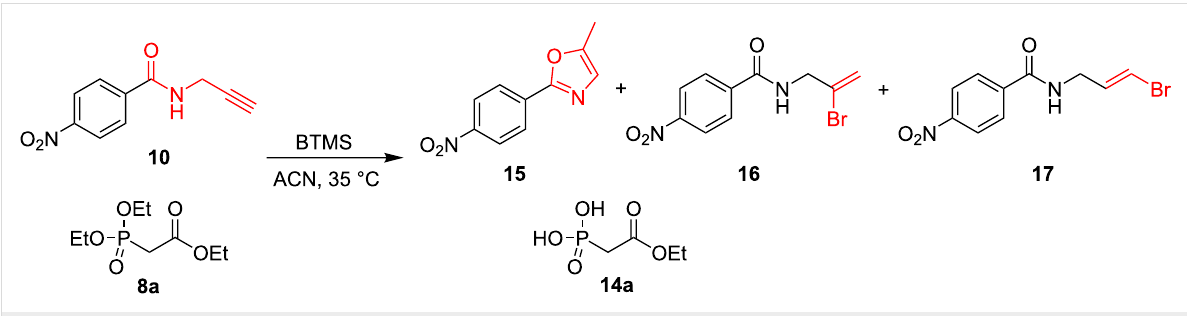
Scheme 2: Formation of the side products derived from 10 . Conditions: An equimolar mixture of propargylamide 10 and triethyl phosphonoacetate ( 8a ) in ACN stirred at 35 °C in the presence of BTMS.